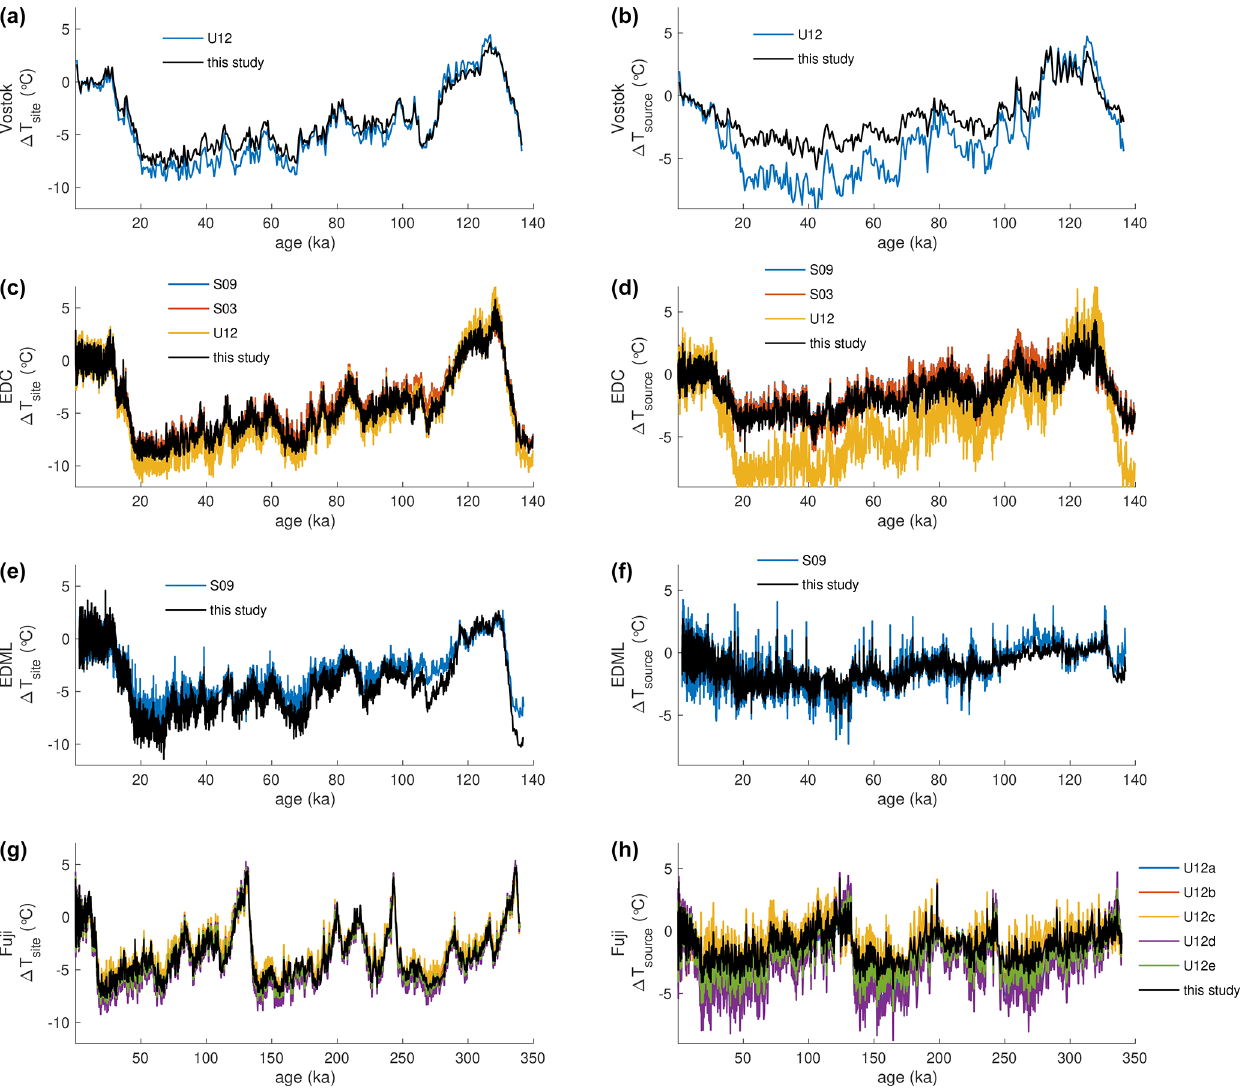
Figure 11. Reconstructions of relative change in Antarctic surface temperature ( (cid:49)T site , left panels) and source region evaporation tempera- ture ( (cid:49)T source , right panels) for four East Antarctic ice-core site: Vostok, EDC, EDML, and Dome Fuji. The nonlinear reconstructions (this study) are shown in black, while published linear reconstructions are shown for each site in color. The linear coefficients for the published reconstructions are compiled in Uemura et al. (2012) (see Tables 1 and 2). Linear methods labeled U12 for Vostok, EDC, and EDML were calculated by a simple Rayleigh-type model (Uemura et al., 2012). Reconstructions U12a–e for Dome Fuji represent a sensitivity study from Uemura et al. (2012). Reconstructions S03 and S09 are from Stenni et al. (2004,